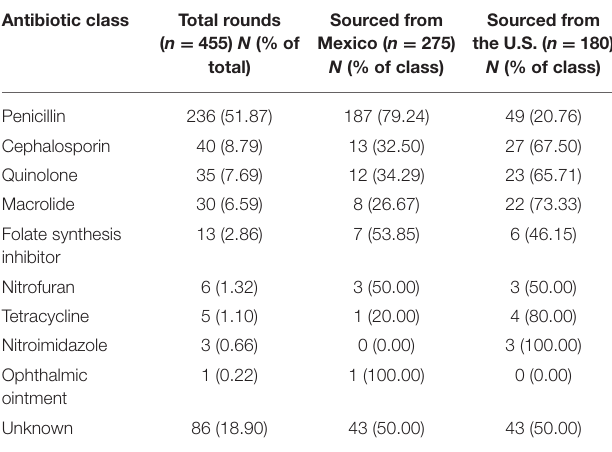
TABLE 2 | Number of respective antibiotic classes used in the 12 months prior to baseline by source country. Antibiotic